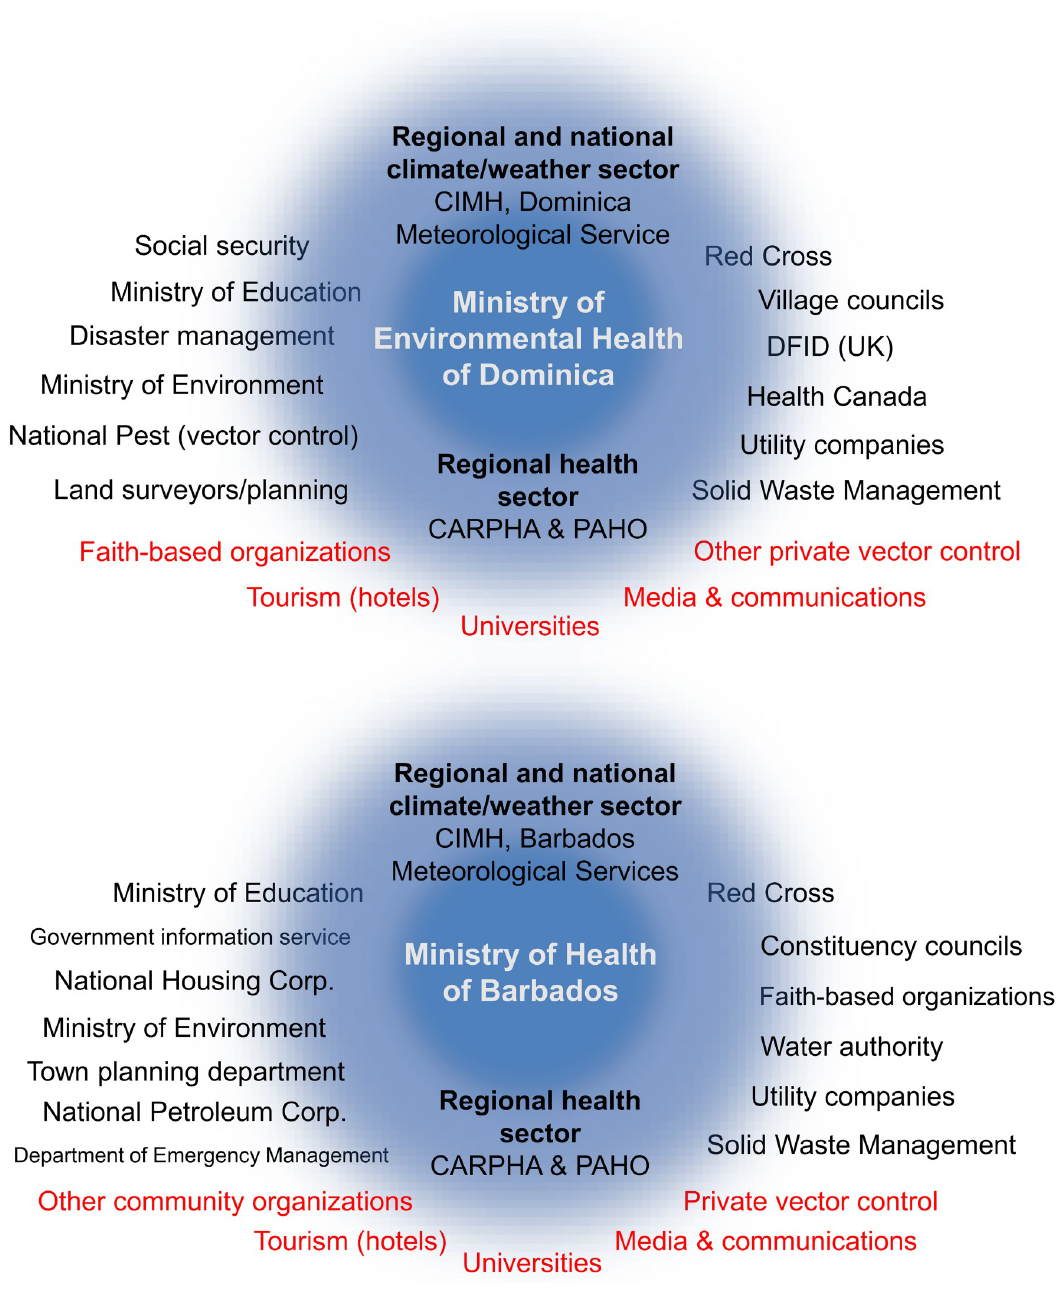
Fig 2. Stakeholder analysis. Organizations that partner with the health sector (in white) in Barbados and Dominica on issues related to vector control and climate services for health. Organizations in black are current functioning partnerships. Organizations in red are partnerships that need to be strengthened with the health